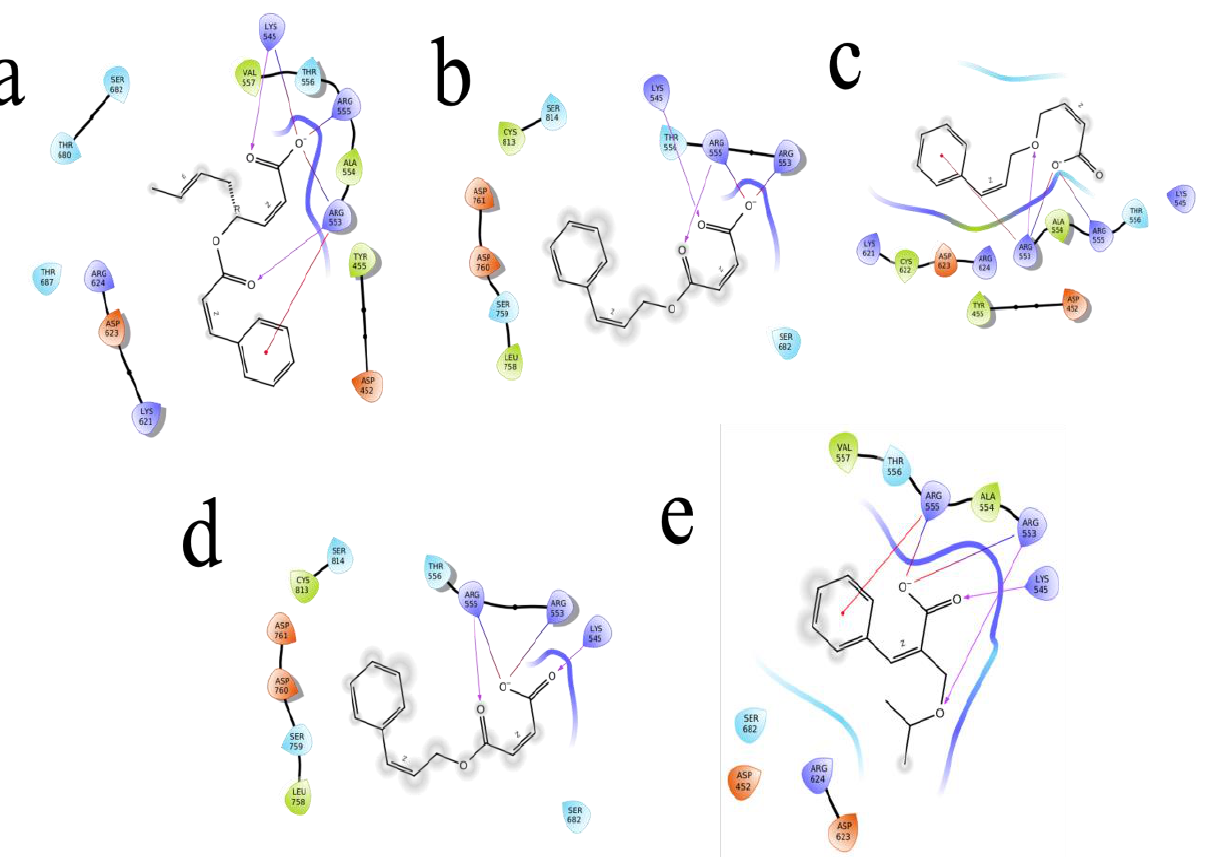
Figure 6. The 5 highest-ranked compounds represented with the RDRP protein of their two-dimensional interactive diagram as R1 ( a ), R2 ( b ), R3 ( c ), R4 ( d ), and R5 ( e ). Epoxy and carboxylic side chains exhibited the highest levels of interactivity among the top 5 structures.